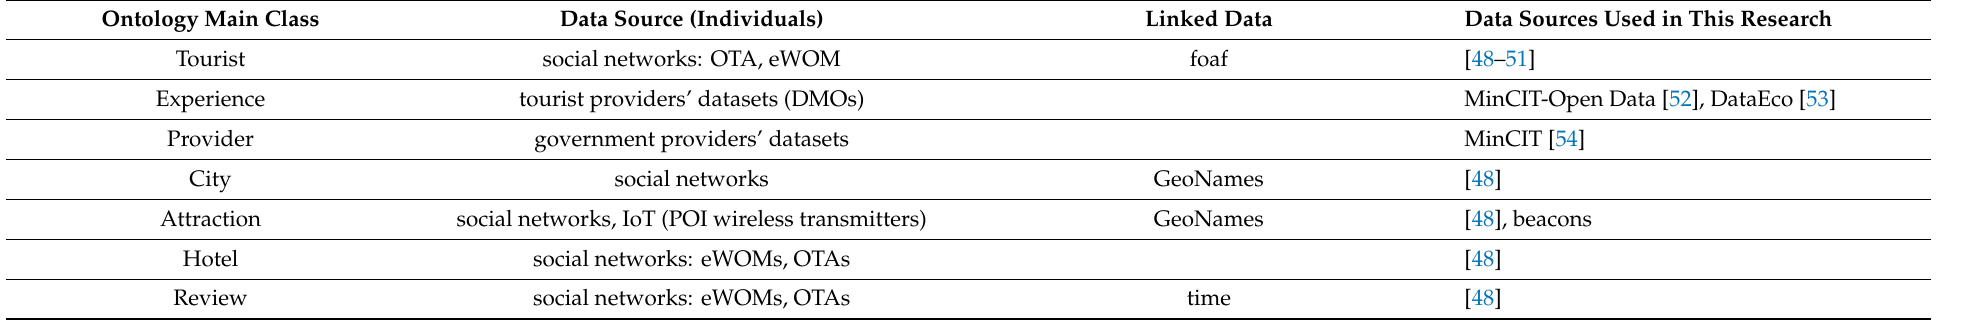
Table 2. Data sources of the individuals of the main classes of OntoTouTra.